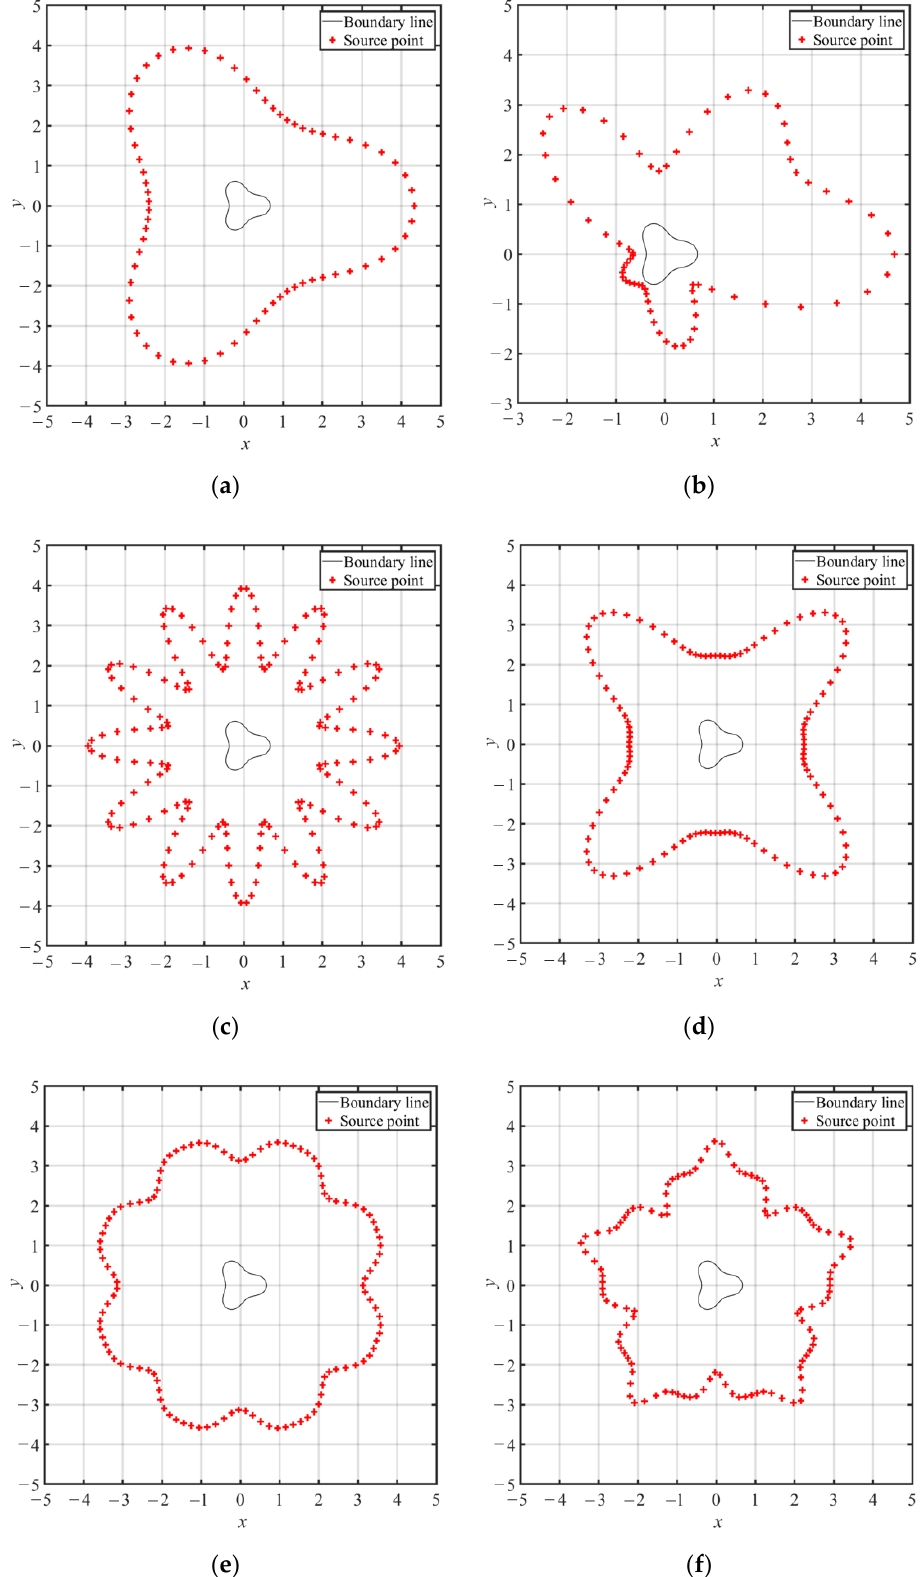
Figure 2. The fictitious sources at different positions: ( a ) Case I; ( b ) Case II; ( c ) Case III; ( d ) Case IV; ( e ) Case V; ( f ) Case VI.